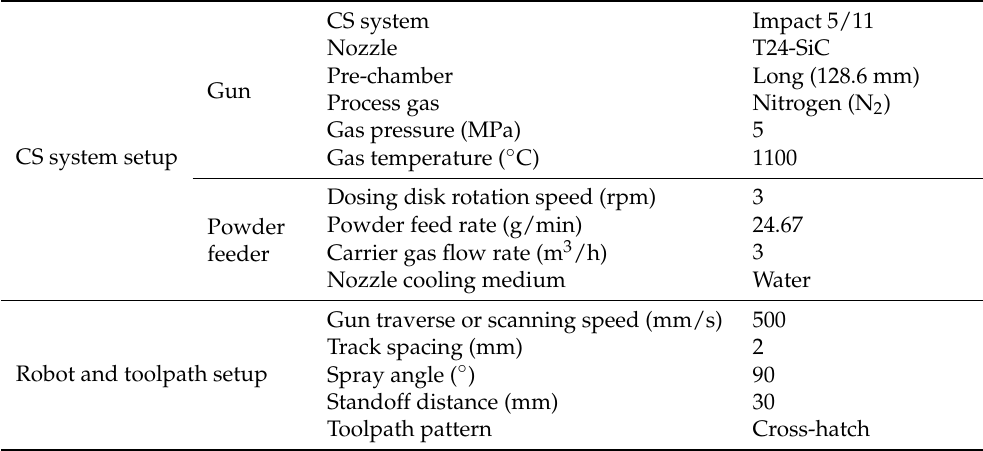
Table 1. Spraying conditions used to deposit Ti6Al4V